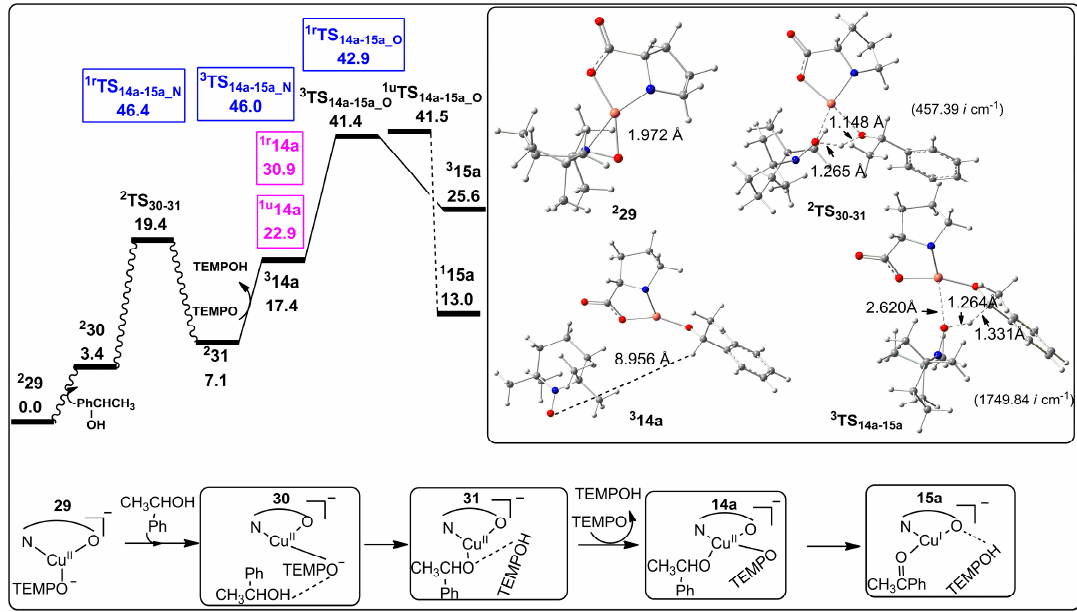
Figure 3. The calculated Gibbs free energy profiles and the optimized geometries for path F. The dashed line represents the singlet state; the solid blue line represents the triplet spin state; the wave line represents the doublet state. The energy values are in kcal/mol.